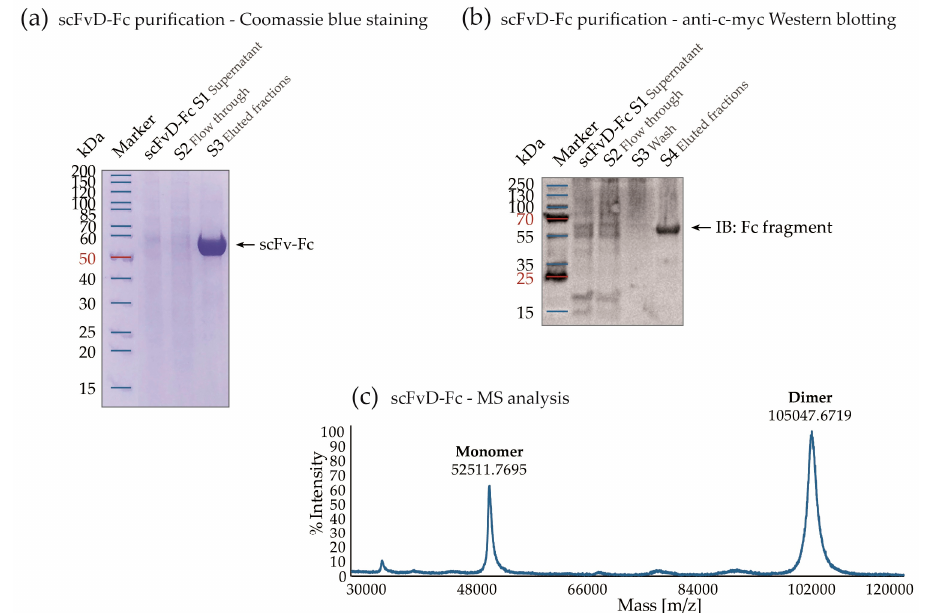
Figure 7. Purification and analysis of scFv-Fc fusions at an example of scFvD-Fc. ( a ) SDS-PAGE and Coomassie brilliant blue staining of the scFv-Fc purification steps; ( b ) Western blot analysis of the scFv-Fc purification process. The membrane was stained with anti-human IgG Fc fragment HRP-conjugated antibody; ( c ) The representative mass spectrum of purified scFv-Fc. The detected m/z peaks correspond to a covalent dimer and monomer of the scFv-Fc protein.